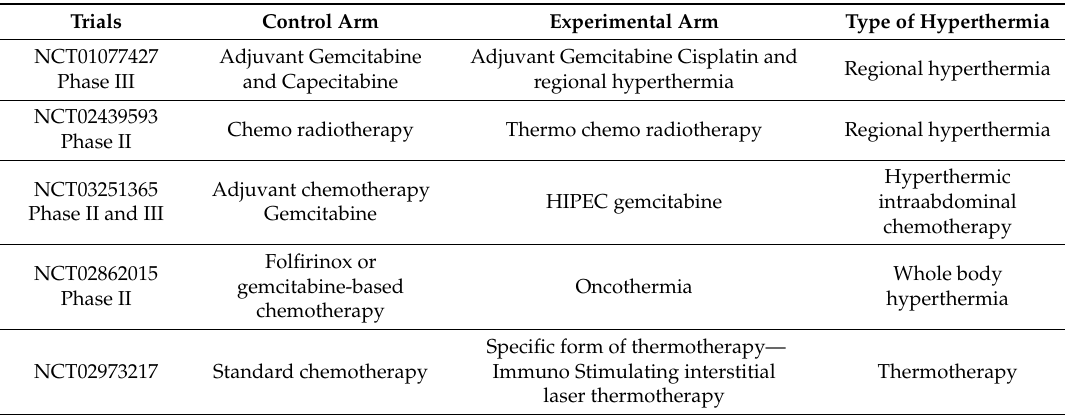
Table 1. Pancreatic Cancer Clinical Trials with